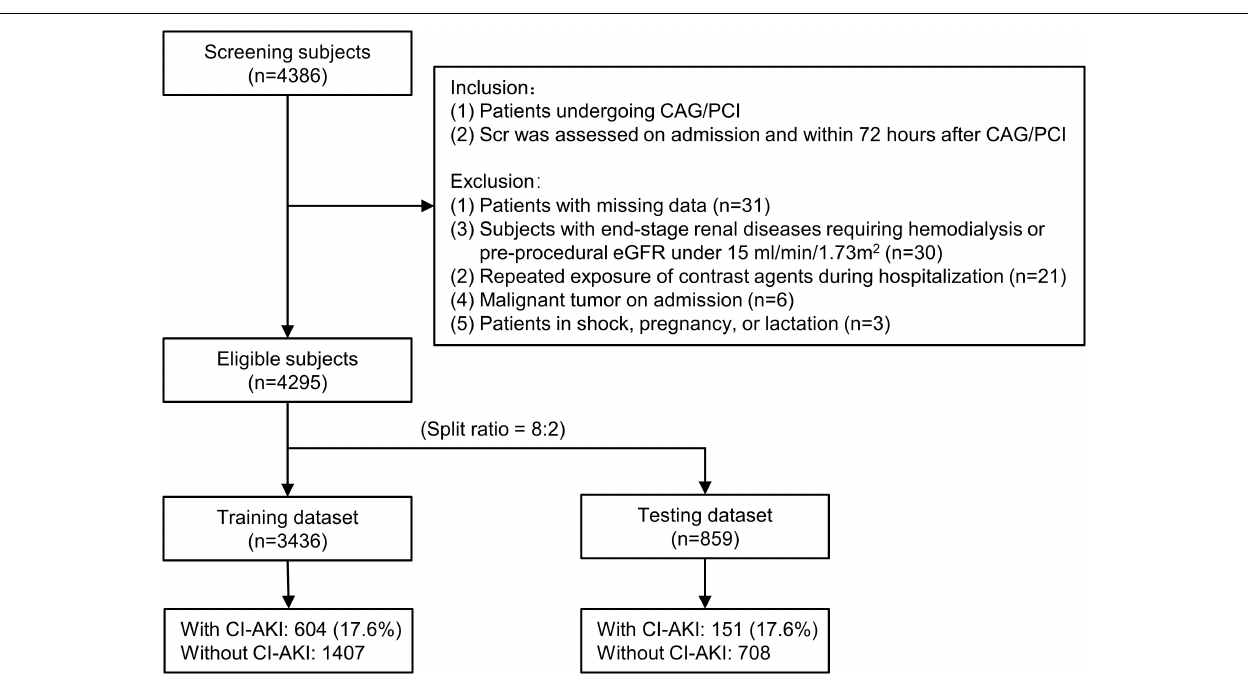
(NT-proBNP), C-reactive protein (CRP), hemoglobin, total cholesterol, cardiac troponin I (cTnI), neutrophil-to-lymphocyte ratio (NLR), glycated hemoglobin A1c (HbA1c), and